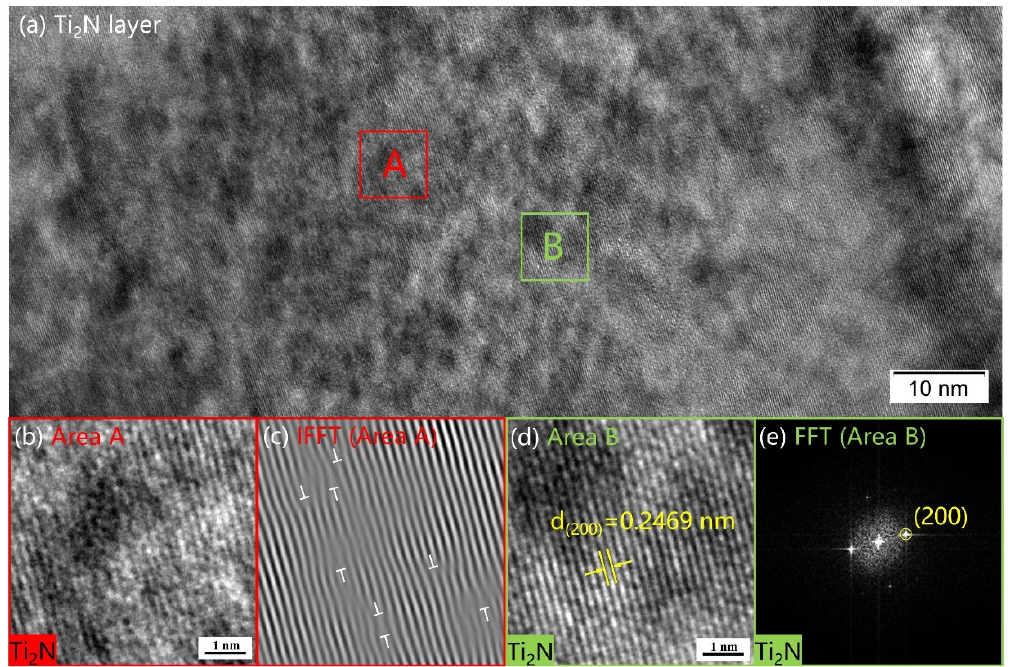
Figure 8. ( a ) The HRTEM image of the Ti 2 N layer; ( b ) The image of area A; ( c ) The IFFT image of area A. Large dislocation distribution within Ti 2 N layers; ( d ) The image of area B; ( e ) The FFT image of area B.